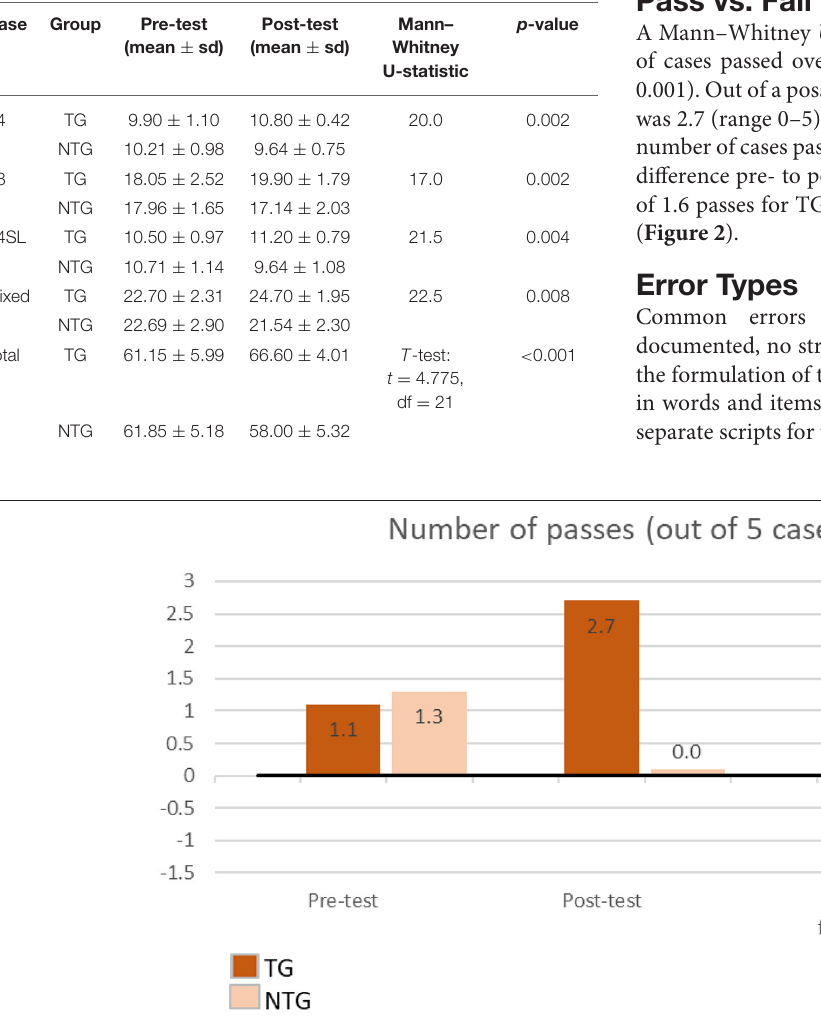
TABLE 2 | Mean individual case scores pre- and post-test for the TG and NTG.